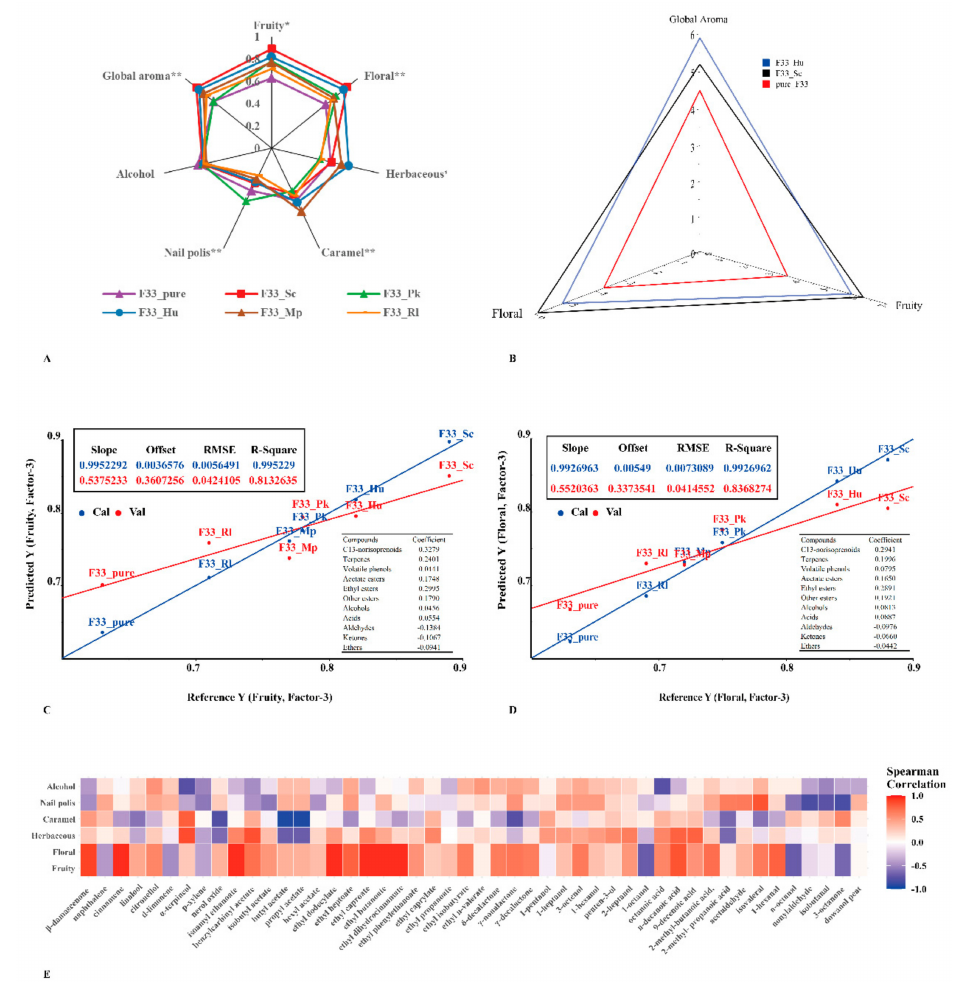
Figure 7. The sensory evaluation of Vidal icewine fermented with six fermentation strategies. pure_F33: S. cerevisiae F33 monoculture. F33_Hu: co-inoculation of S. cerevisiae F33 and H. uvarum QTX22. F33_Sc: co-inoculation of S. cerevisiae F33 and S. crataegensis Y30. F33_Mp: co-inoculation of S. cerevisiae F33 and M. pulcherrima YC15. F33_Pk: co-inoculation of S. cerevisiae F33 and P. kluyveri HSP11. F33_Rl: co-inoculation of S. cerevisiae F33 and R. lusitaniae QTX26. ( A ) Modified frequency (MF) values of aroma characteristics in six fermentation strategies. * and **, significant at p < 0.05 and 0.01, respectively. ( B ) The analysis results of triangular tests. Grades ranked from 0 (poorly intense) to 7 (very intense). ( C , D ) PLS regression of fruity ( C ) and floral ( D ) aroma volatiles. Val, validation; Cal, calibration. ( E ) Correlation analysis between major aroma substances (OAV > 1) and sensory